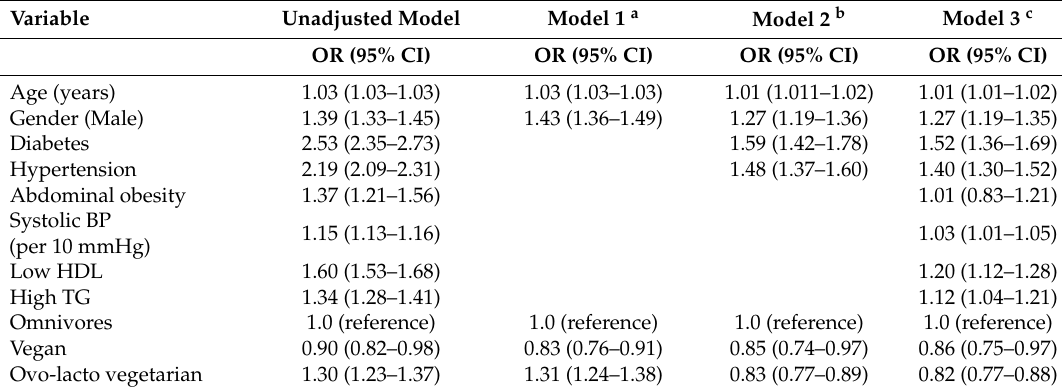
Table 2. Logistic regression analysis of the presence of chronic kidney